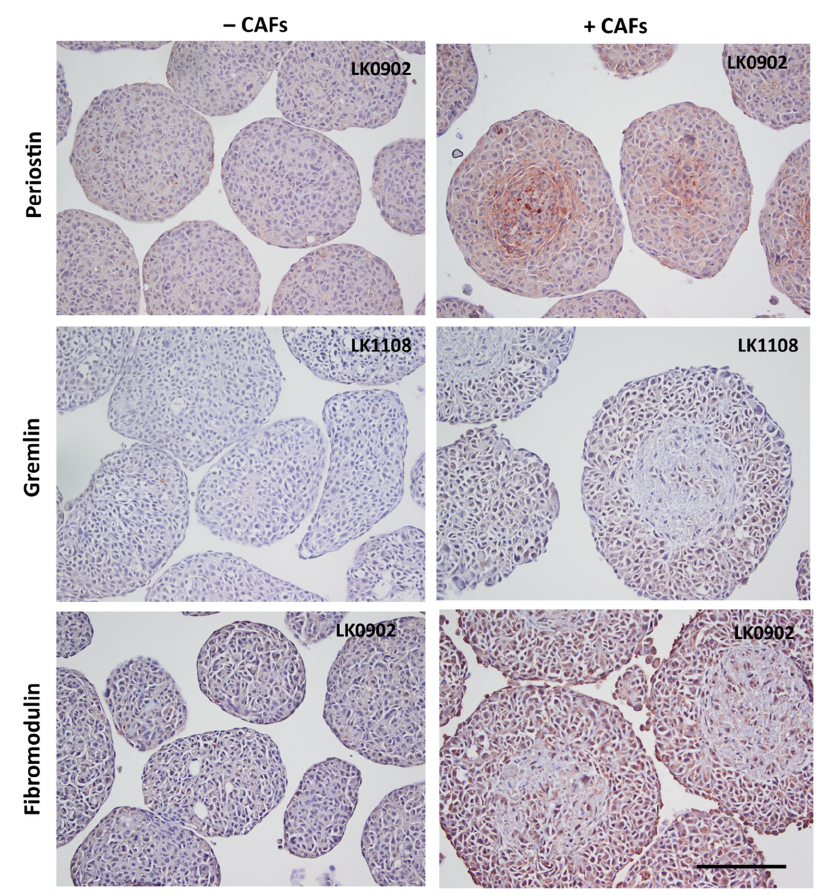
Figure 4. Verification of microarray with immunohistochemistry. Expression of periostin, gremlin, and fibromodulin in 5-day-old tumor cell spheroids (±CAFs) by immunohistochemical staining. Scale bar = 200 µm.